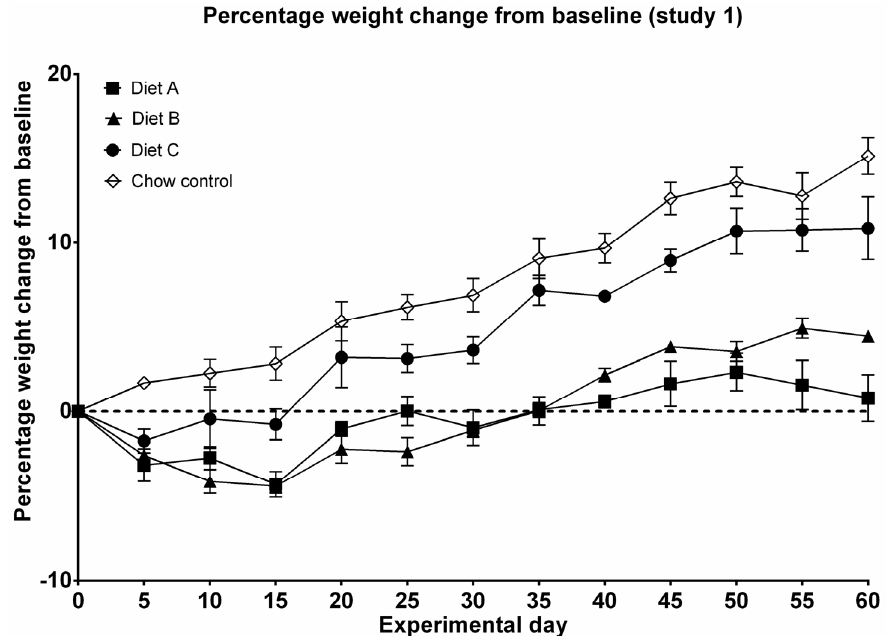
Figure 2. Percentage of weight change from baseline (study 1). Data are presented as mean ± SEM. Weight was measured daily, however, data points represent weigh every 5